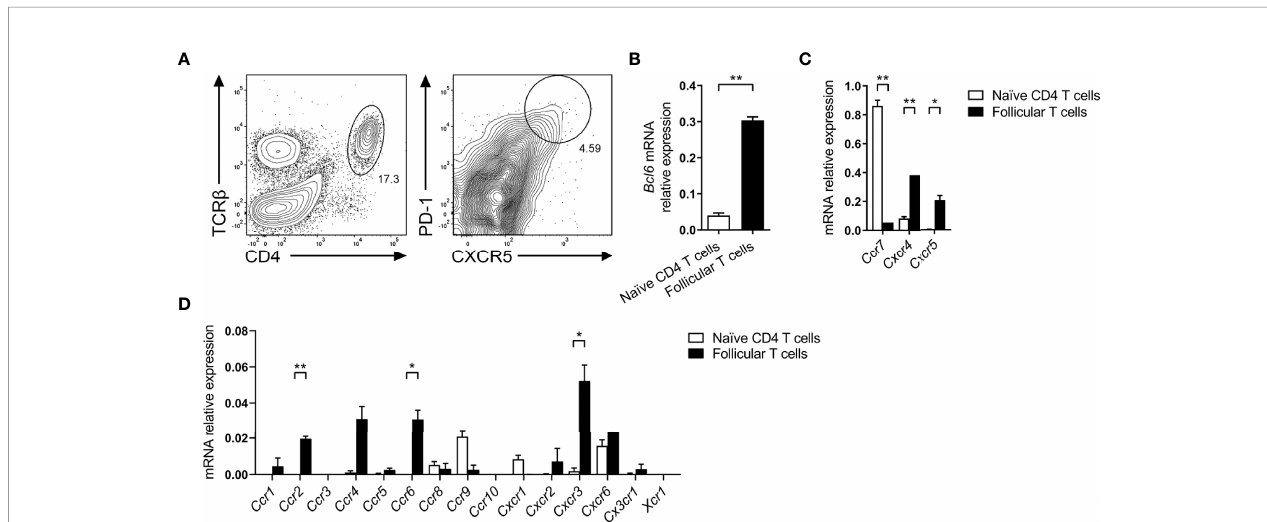
FIGURE 1 | Chemokine receptor gene expression by follicular T cells. (A) Representative gating strategy for sorting follicular T cells (CD4 + TCR b + CXCR5 hi PD-1 hi ) from day 5 SRBC i.p. immunized mice. Expression of (B) follicular T cell master transcription factor Bcl6 , (C) known follicular T cell-tropic chemokine receptors, and (D) all other known classical chemokine receptors, between in naïve CD4 T cells (CD4 + CD44 - CD62L + ) and follicular T cells, relative to Gapdh . (B – D) Data pooled from two independent experiments with 3 mice pooled per time point ± SEM, two-tailed unpaired Student ’ s t test. *p < 0.05, **p <